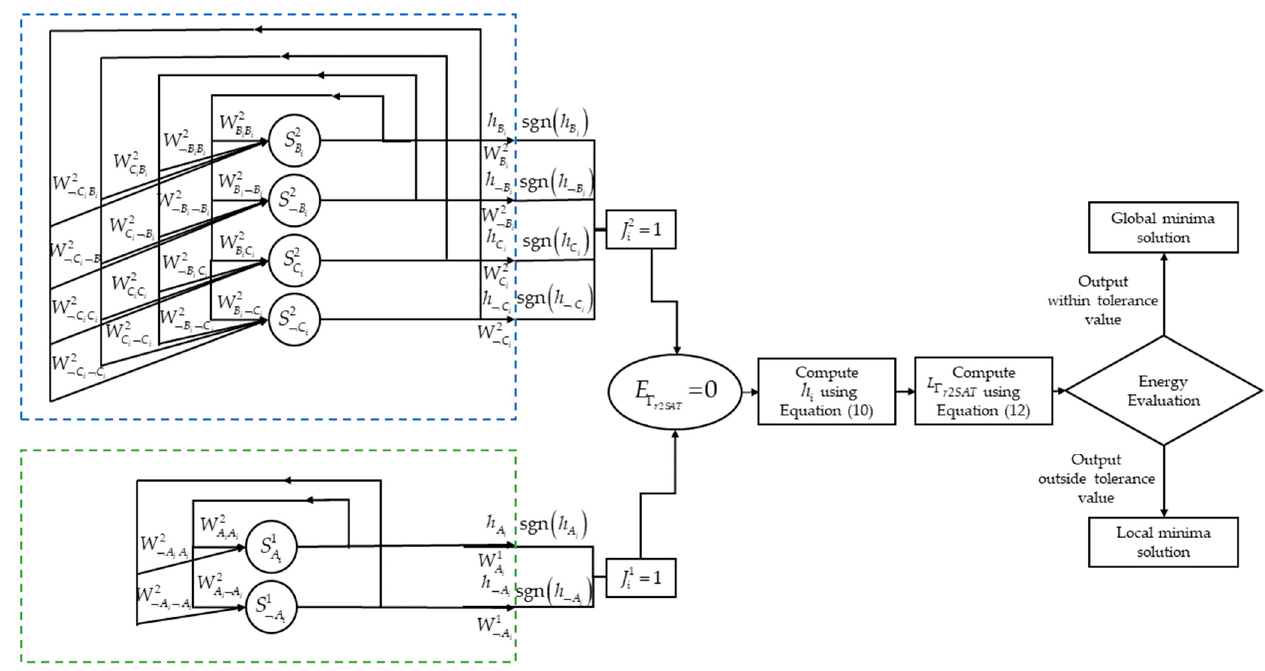
Figure 2. Schematic Diagram for DHNN- r 2SAT.